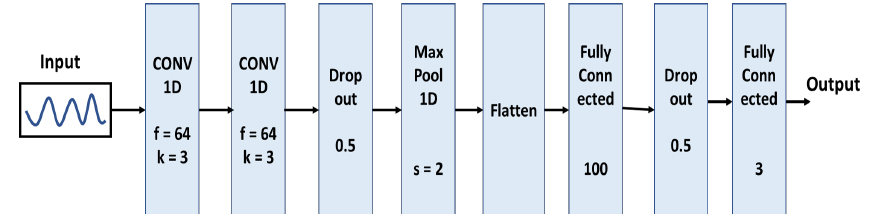
Figure 4. 1D CNN Architecture for fNIRS Signals Classification.